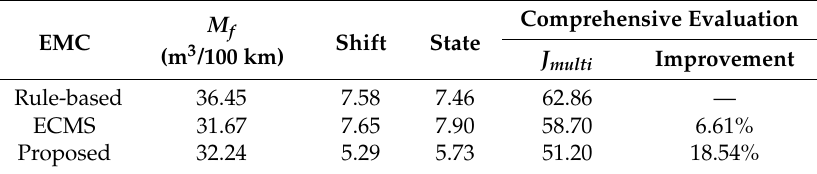
Table 4. Comprehensive performance